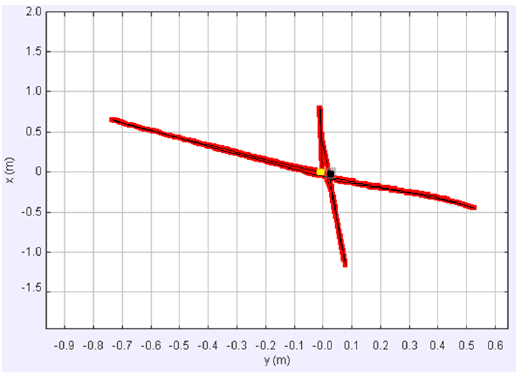
Figure 24. The path in Figure 23 shown by Tracker.